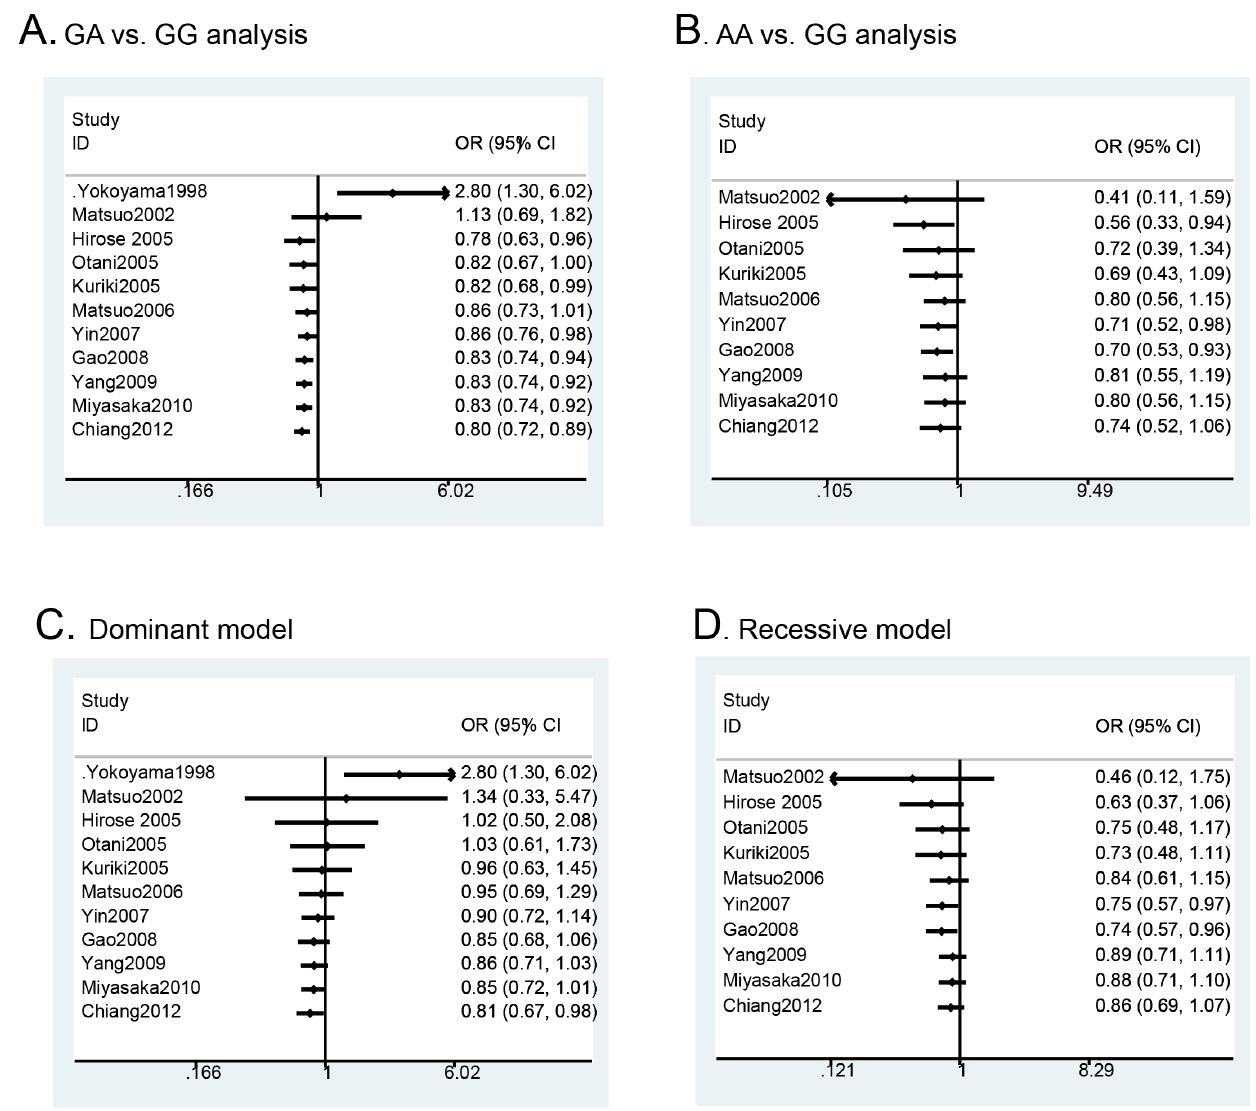
Figure 3. Cumulative meta-analysis of ALDH2 Glu487Lys polymorphism and colorectal cancer: A) GA vs. GG analysis according to publication year; B) Dominant model analysis according to publication year.